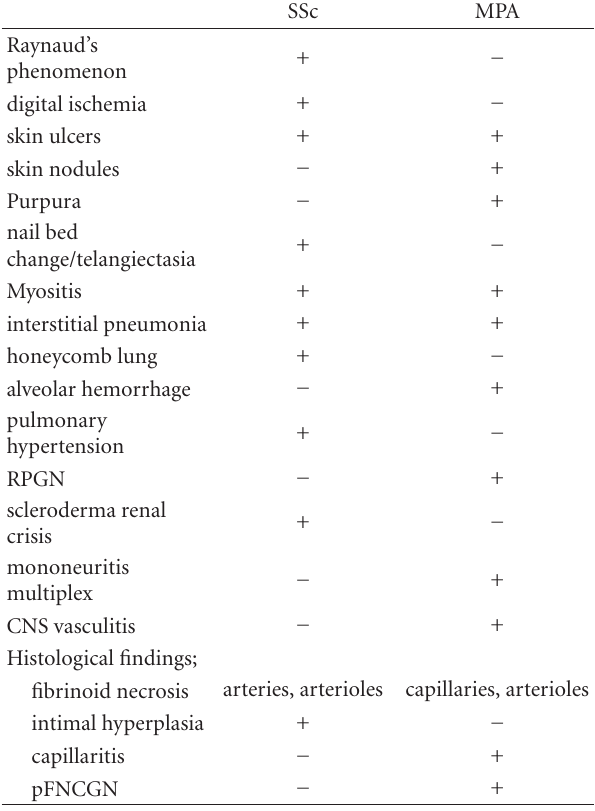
Table 3: Di ff erences in vascular clinical findings between SSc and